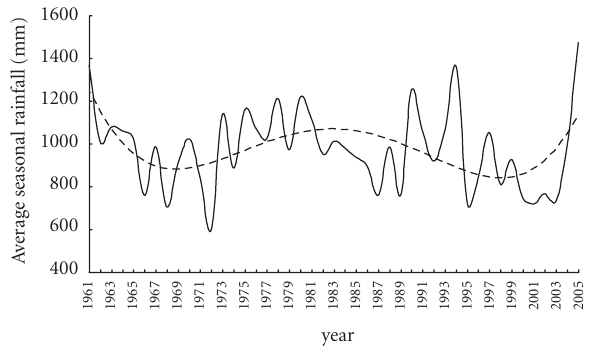
Figure 4: Yearly variation of average seasonal rainfall over the Koyna catchment.